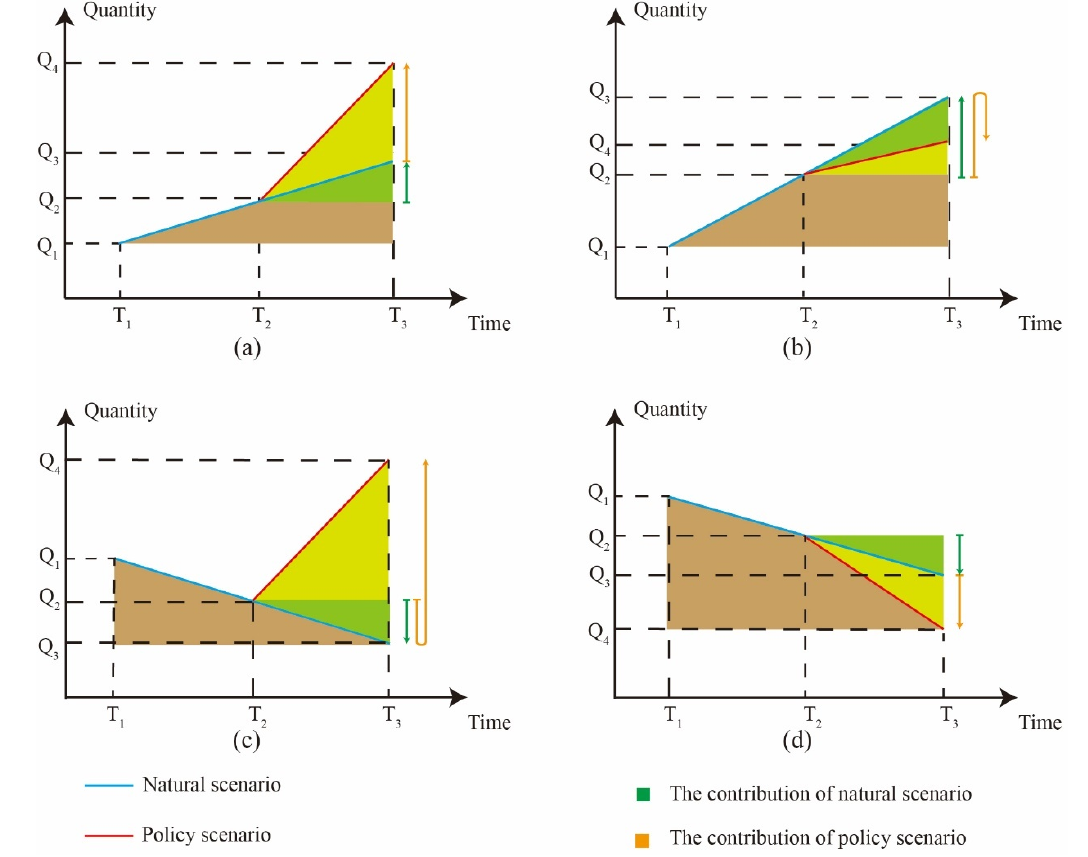
Figure 4. Conceptual map of the contribution of policy and natural context to LUCC. ( a ) Both natural and policy scenarios contribute positively to LUCC. ( b ) The natural scenario has a positive contribution, but the policy scenario has a negative contribution. ( c ) The policy scenario has a positive contribution, but the natural scenario has a negative contribution. ( d ) Both policy and natural scenarios have negative contributions. The natural scenario is the scenario less influenced by policy, and the policy scenario is the scenario influenced by both natural scenarios and policy. Q 3 : number of a certain land use type at time T 3 under the natural scenario. Q 4 : number of a certain land use type at time T 3 under the policy